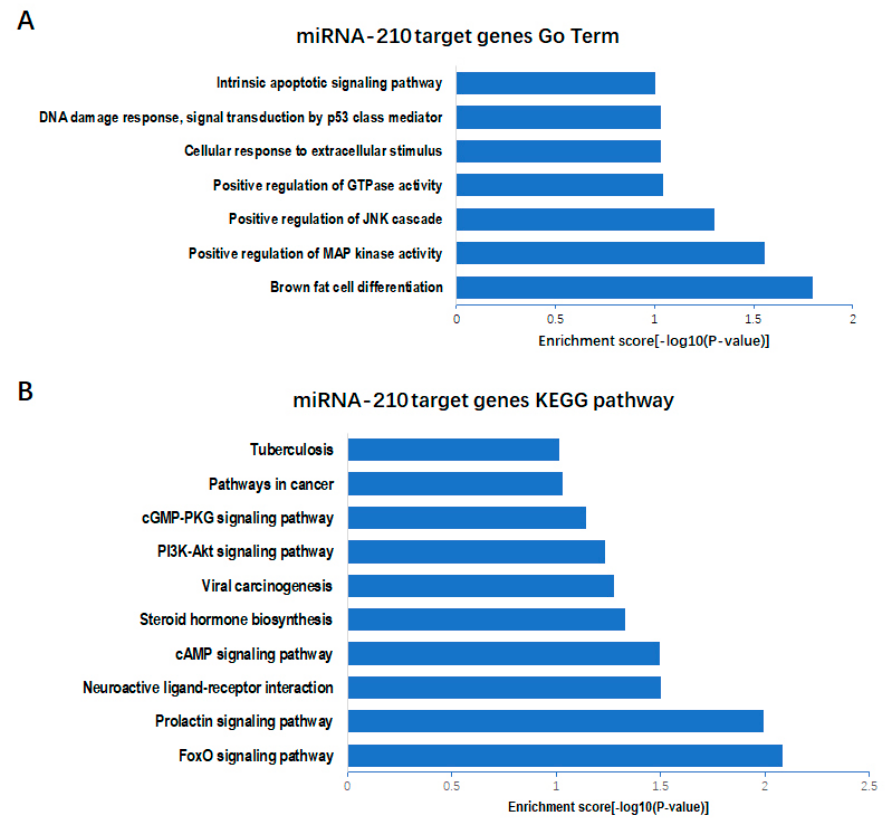
Figure 4. GO(gene ontology) and Kyoto Encyclopedia of Genes and Genomes (KEGG) analysis of miR-210 target genes. ( A ) GO term analysis of the bta-miR-210 target genes. ( B ) KEGG pathway analysis of the bta-miR-210 target genes.